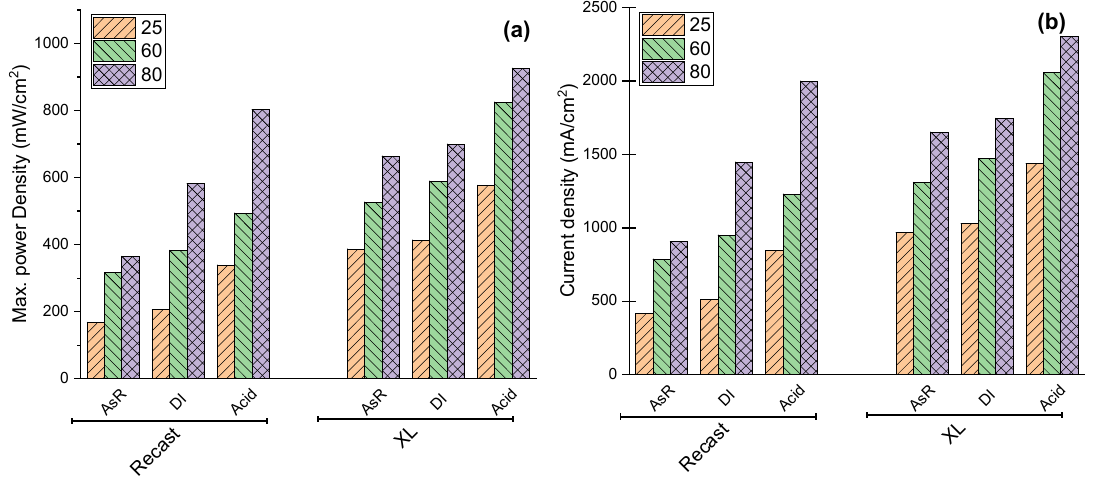
Figure 4. Influence of temperature on the single cell performance of treated and un-treated mem- branes at 25, 60 and 80 ◦ C Maximum power density ( a ) and current density at 0.4 V ( b ). As can be seen, the acid-treated membrane showed improved performance with increasing temperature. For all membranes, the highest power density was achieved at 80 ◦ C. Additionally, the trends in current density change in Figure 4 (b) follow those for the maximum power